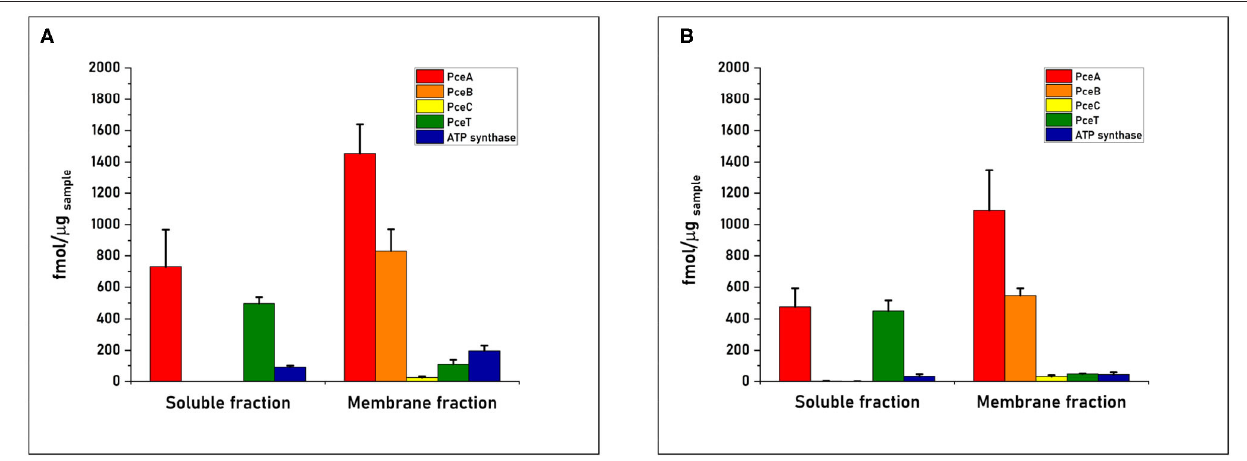
FIGURE 4 | Quantitative proteomics of the Pce proteins and the F1 α -subunit of the ATP synthase in sub-cellular compartments obtained from cell-free extracts of (A) D. restrictus and (B) D. hafniense strain TCE1. These graphs shows the results of one biological replicate and are representative of the trend also observed for the second replicate (see Supplementary Table 2 ). The concentration of each protein was calculated by averaging the values obtained for the selected peptides in technical triplicates. Error bars indicate the calculated standard